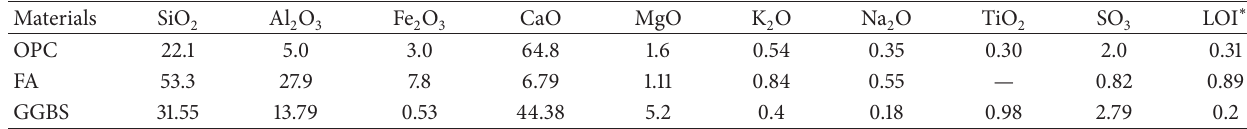
Table 1: Chemical composition of the cementitious materials (% by